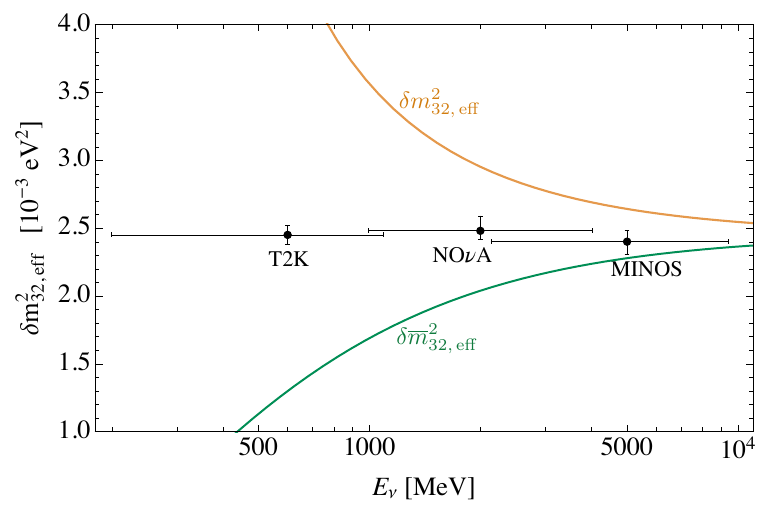
Figure 5 . The effective ‘atmospheric’ mass-squared splitting predicted by the toy model for both neutrinos ( δm 2 ) and antineutrinos ( δm 2 32 ,eff (cid:12) = 0 . 003 , E res θ ∼ 300 MeV, and E res (cid:12) ν 3 S 3 MB points with error bars denote recent combined measurements of δm 2 experiments